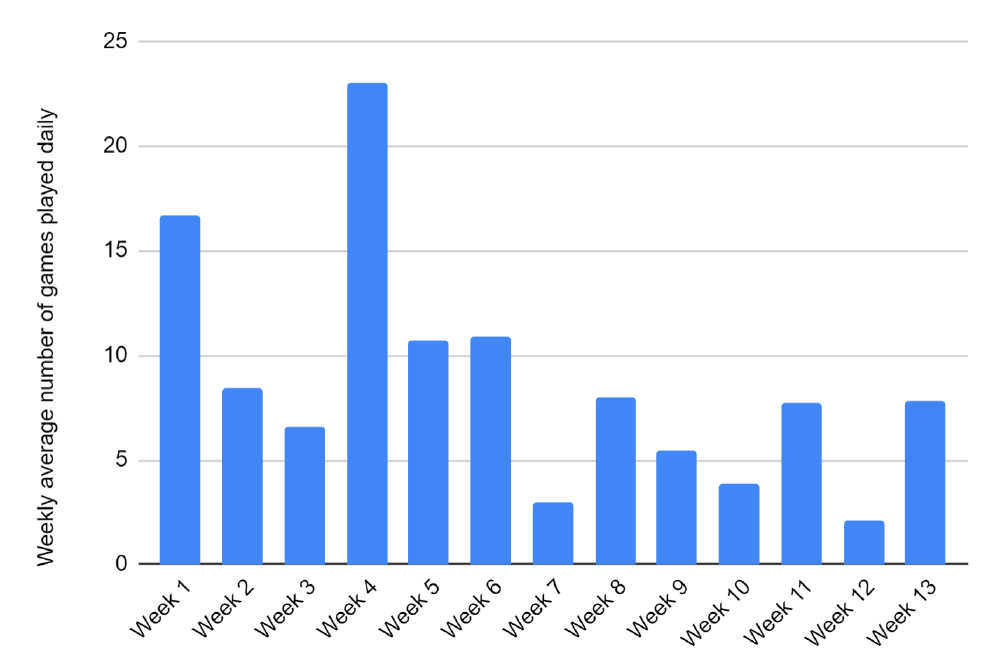
Figure 8. Average number of games played, per